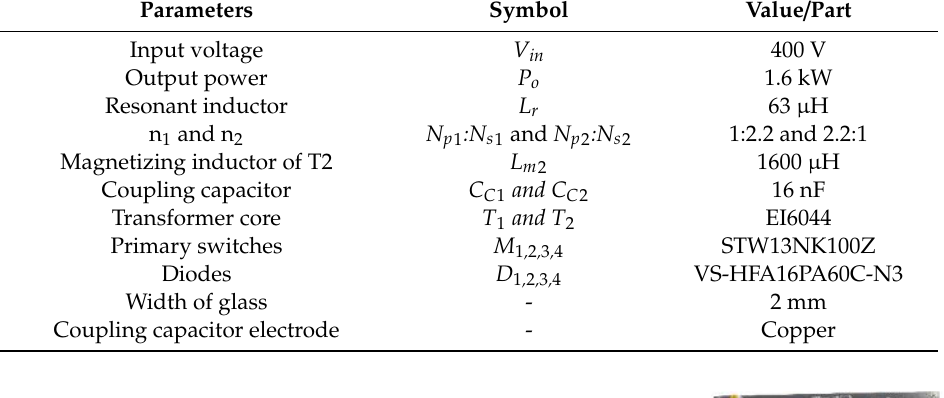
Table 2. Specific Components of Prototype.